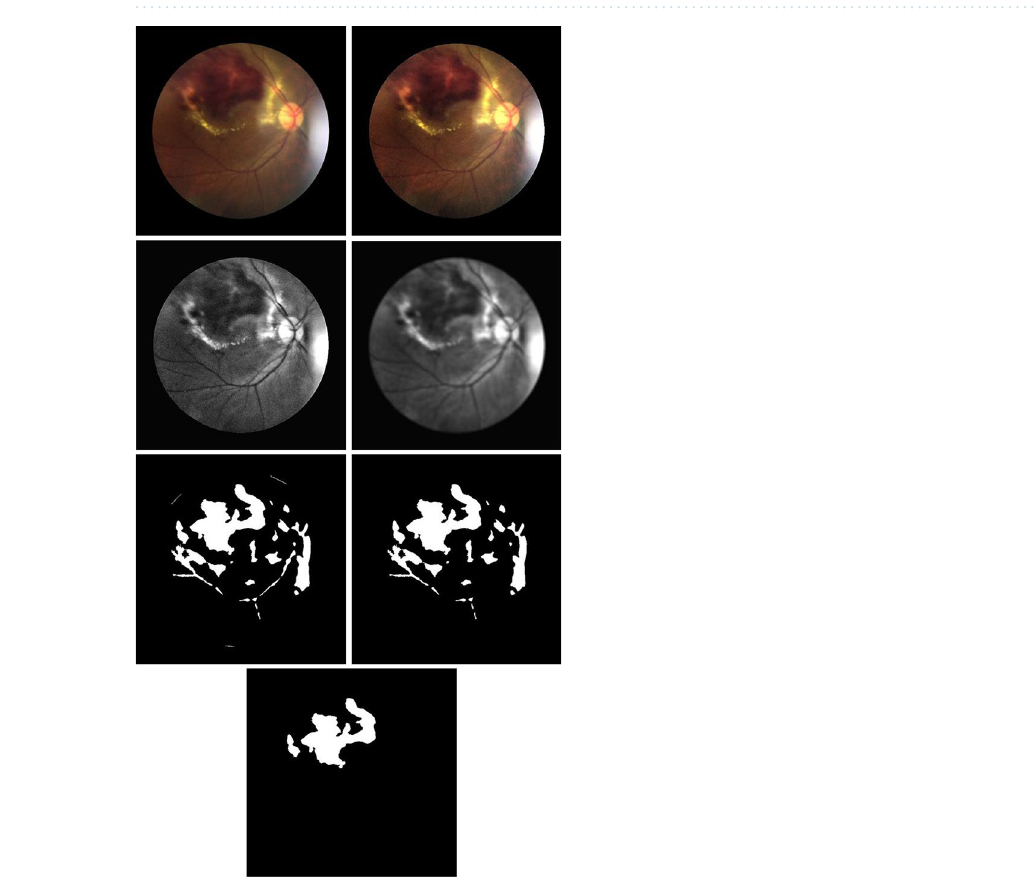
Figure 2. Images of blob regions at different iterations of INRG. The original images ( a ) and regions obtained from the INRG algorithm from the first iteration until it converges ( b–d ).